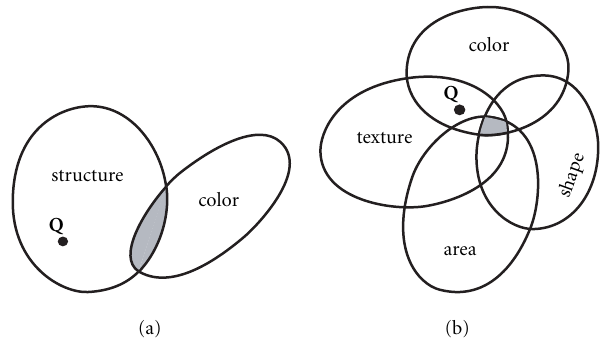
Figure 5: (a) Representation of feature sets describing the semicon- ductor defect substrate in (a) and defect in (b). The intersection of these descriptive sets defines a similar retrieval.